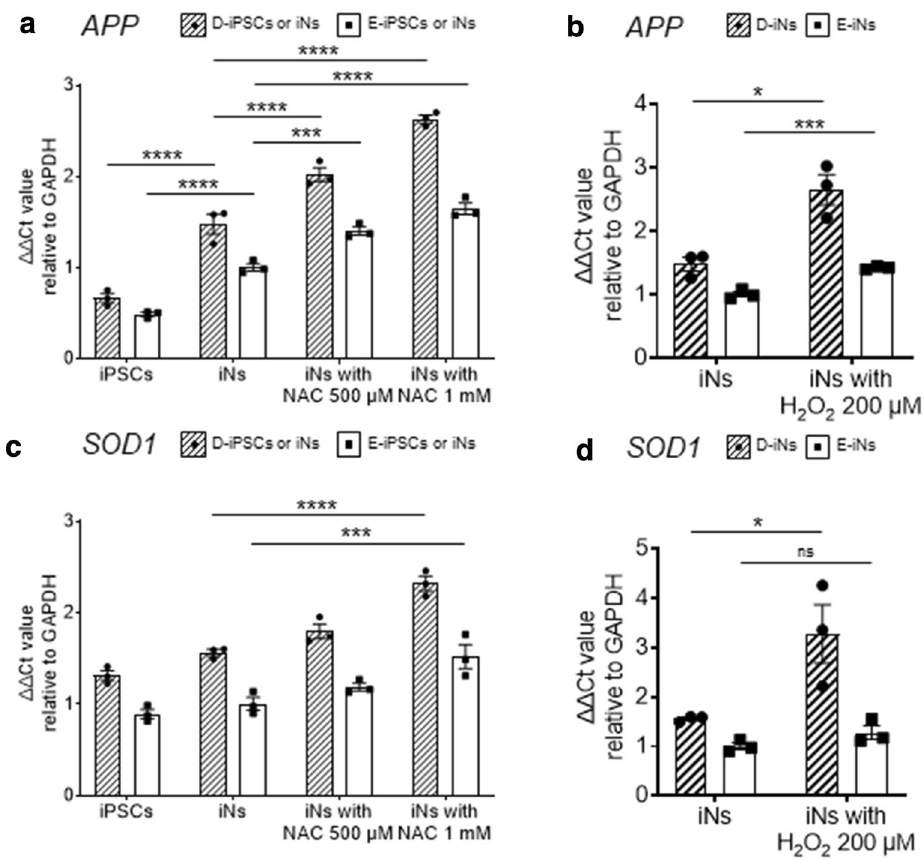
Figure 5. Effects of an oxidant or anti-oxidant on the expression of APP and SOD1 . (a–d) Expression of APP (a,b) and SOD1 (c,d) evaluated by the ΔΔCt method relative to GAPDH. Data were converted into 2 -ΔΔCt values and plotted. NAC or H 2 O 2 at the indicated concentrations were added on day 8, and the samples were collected on day 10. Data are means ± SEM from three independent experiments; ****, p < 0.0001; ***, p < 0.001; **, p < 0.01; two-way ANOVA test followed by Dunnett’s multiple comparison test (a,c) or Student’s t-test (b,d) . Data are normalized to the mean expression levels of control E-iNs. Data for iNs in (a) and (b) and in (c) and (d) are the